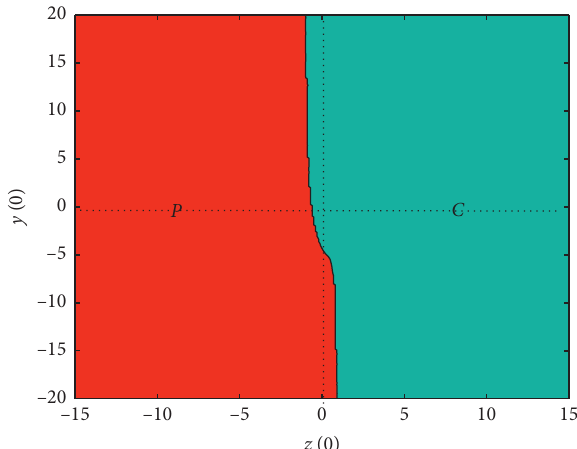
Figure 2: Bifurcation diagram and Lyapunov exponents spectrum of system (2) with initial conditional [ x diagram. (b) Lyapunov exponents (LEs).